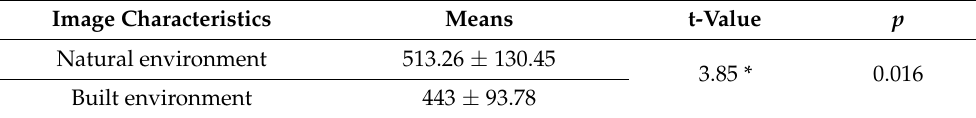
Table 2. Effects of image characteristics on willingness to pay in older consumers.